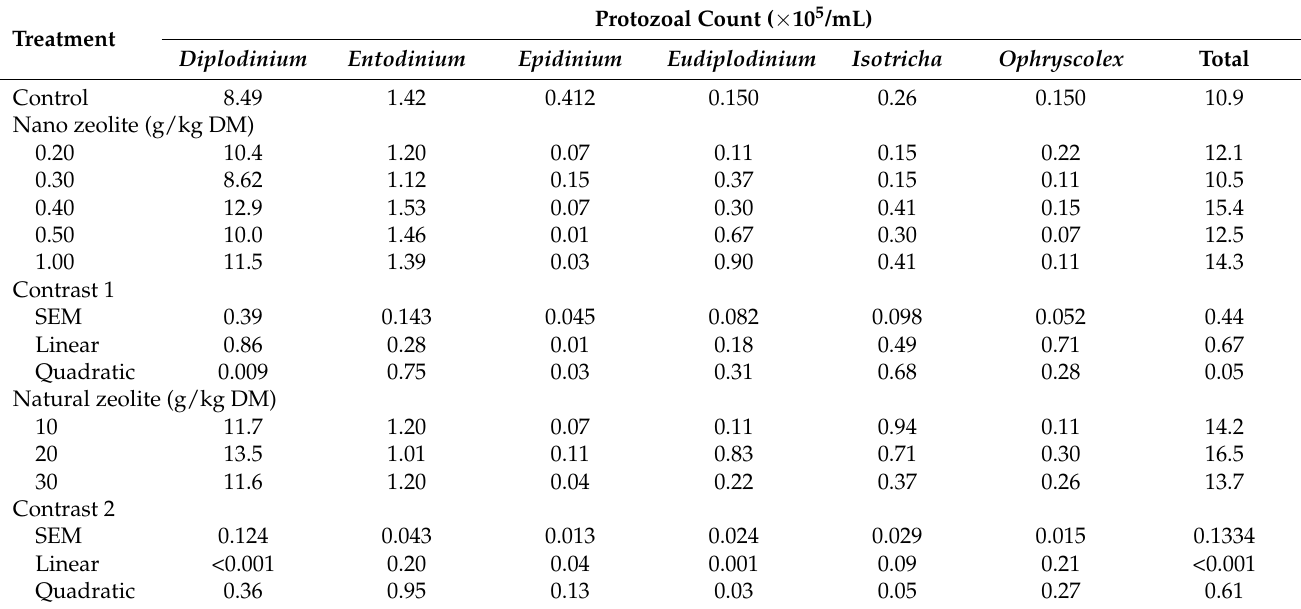
Table 4. Supplementation effects of natural and nano-zeolite forms on ruminal protozoal count through 24 h incubation period ( in vitro